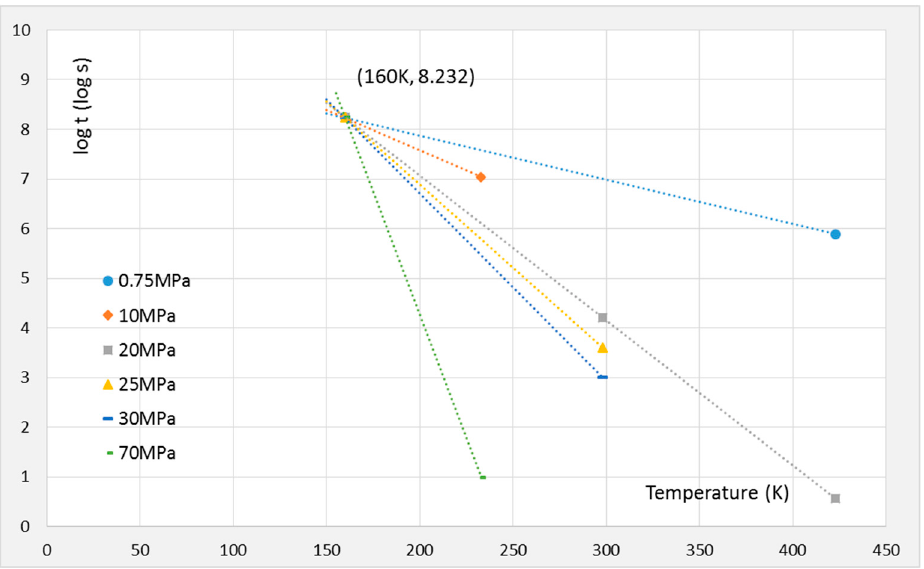
Figure 2. Creep-rupture characteristics of 63Sn37Pb solder. Table 1. Creep-fatigue data for 63Sn37Pb solder.